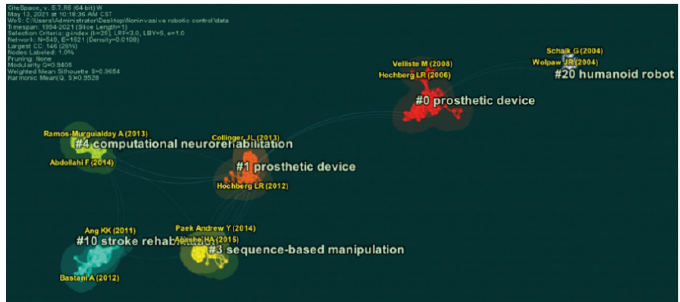
Figure 13. BCI literature review analysis based on CiteSpace [196].